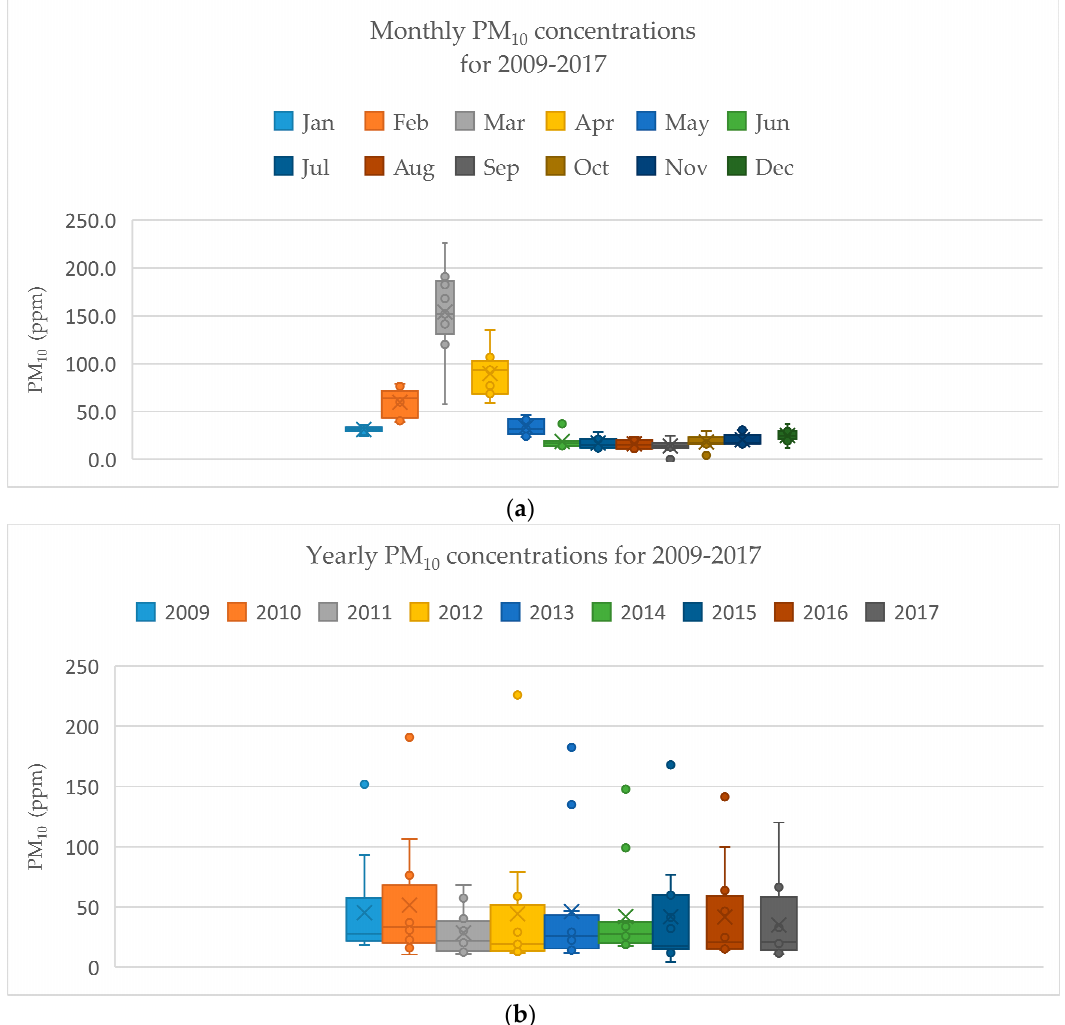
Figure 3. Monthly ( a ) and yearly ( b ) PM 10 concentration in Mae Hong Son Province for 2009–2017.